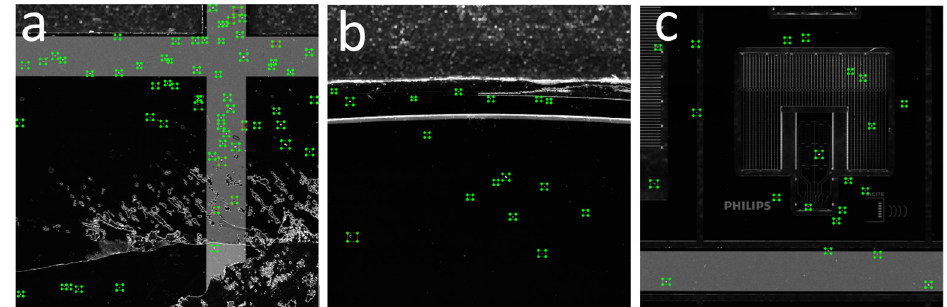
Figure 4. An example of the labelling process. ( a – c ) represent parts of a wafer with shatter, upper edge, and middle part, respectively. Table 2. The number of images and labels used in training, testing, and validation for the plenoptic ADR